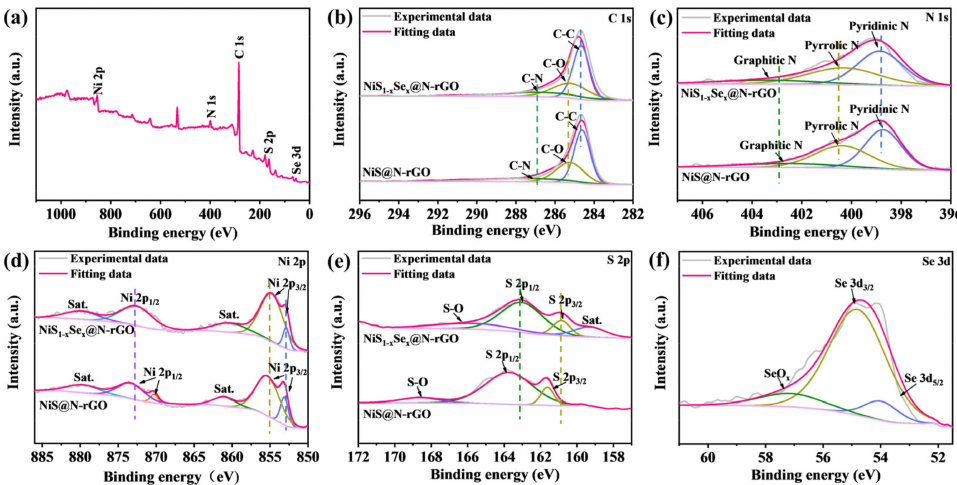
Figure 4. ( a ) XPS survey spectrum of NiS 1 − x Se x @N–rGO. ( b – e ) High-resolution C 1s, N 1s, Ni 2p, and S 2p contrast of NiS@N–rGO and NiS 1 − x Se x @N–rGO composites. ( f ) Se 3d XPS spectrum of NiS 1 − x Se x @N–rGO